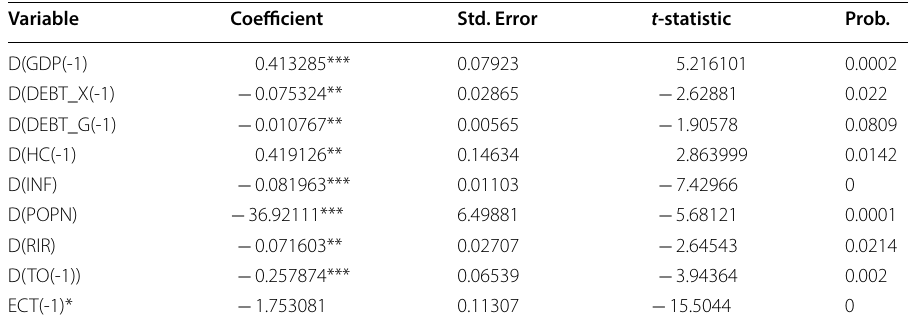
Table 8 Summary of the error correction model results (short run)